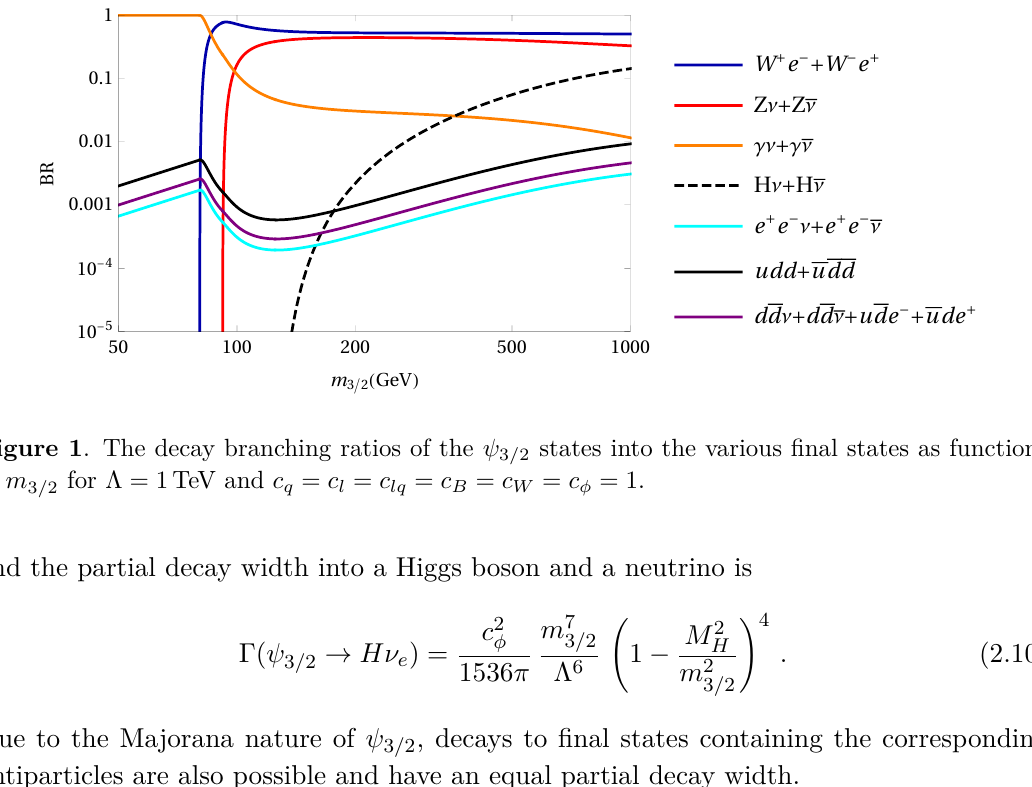
states into the various final states as functions 3 / 2